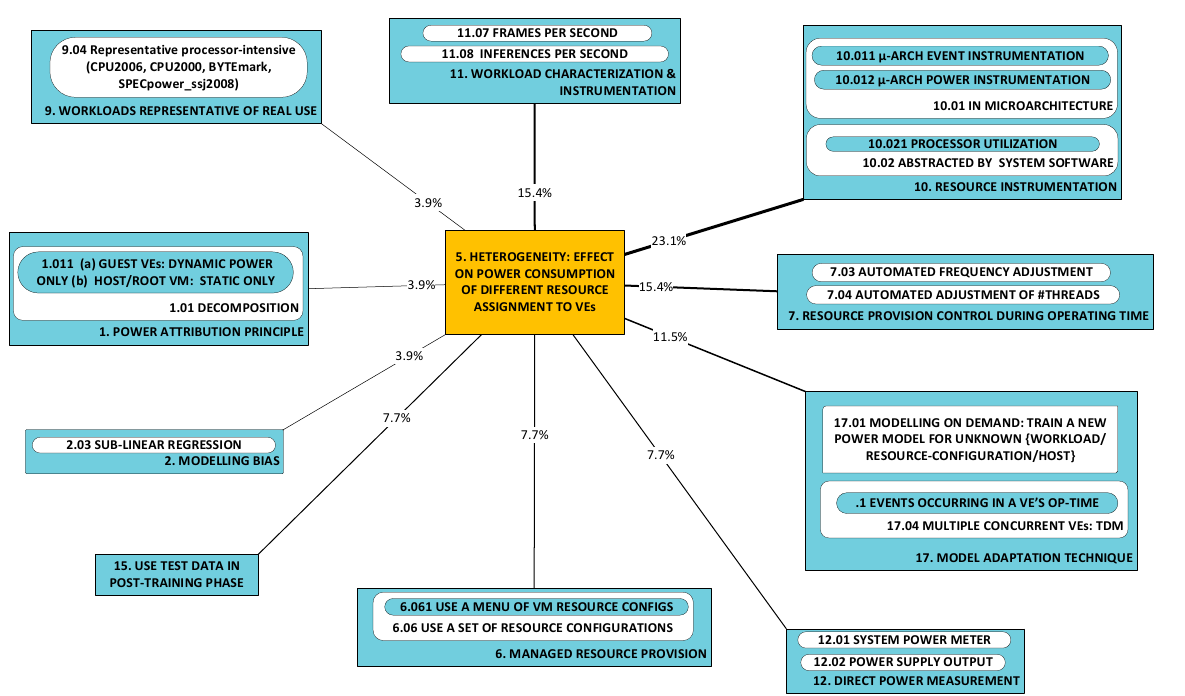
Figure 13. Approaches to solving challenges in category P5; utility metric U A thickness and as a percentage. RUs in the respective categories are the following: P5 [62,72,78];